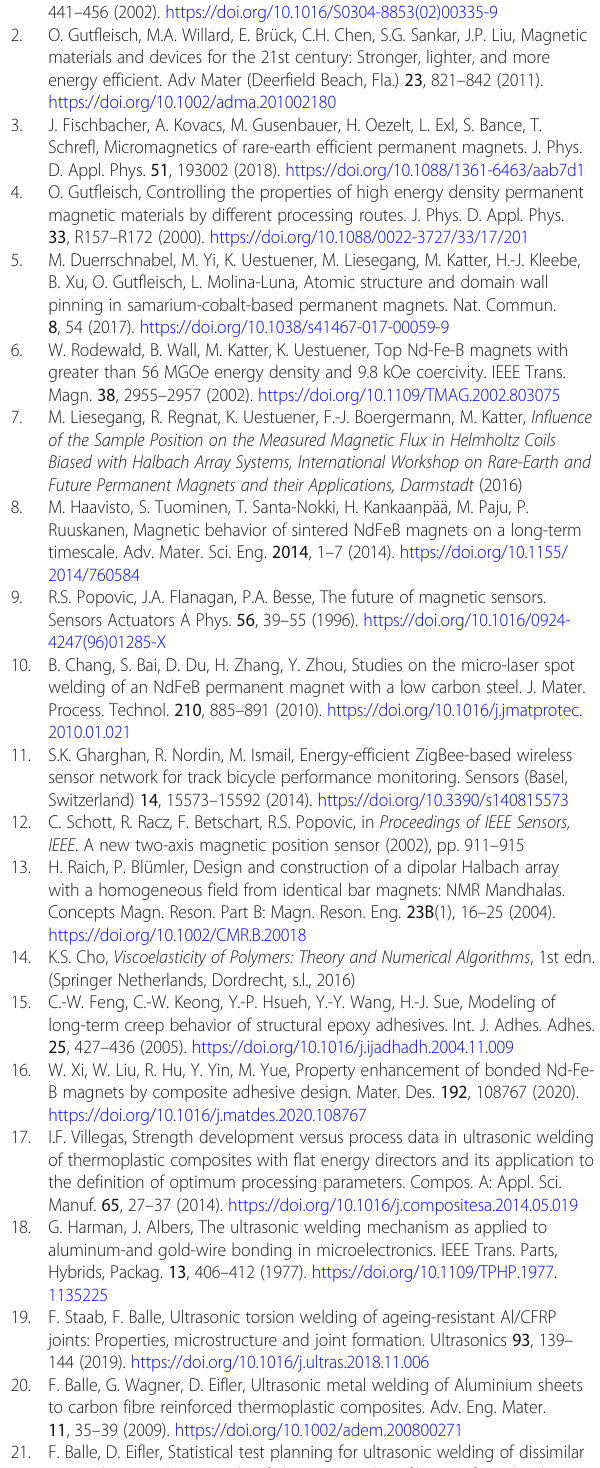
Table 4 Loss of magnetic flux density of the hybrid material systems in relation to a single Nd 2 Fe 14 B magnet in its initial state Loss of magnetic flux density in